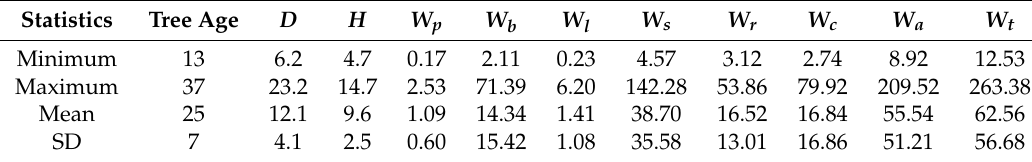
Table 1. Descriptive statistics of the main variables of standard trees (n =